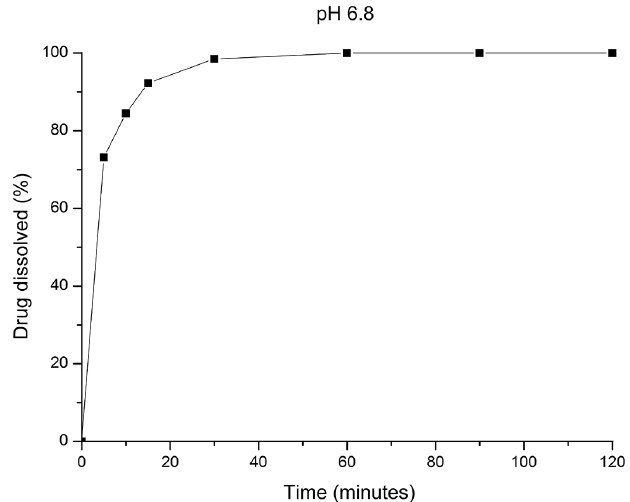
FIGURE 3 - Dissolution profile representing a hypothetical extended-release formulation using USP apparatus 1 in a pH 6.8 buffer